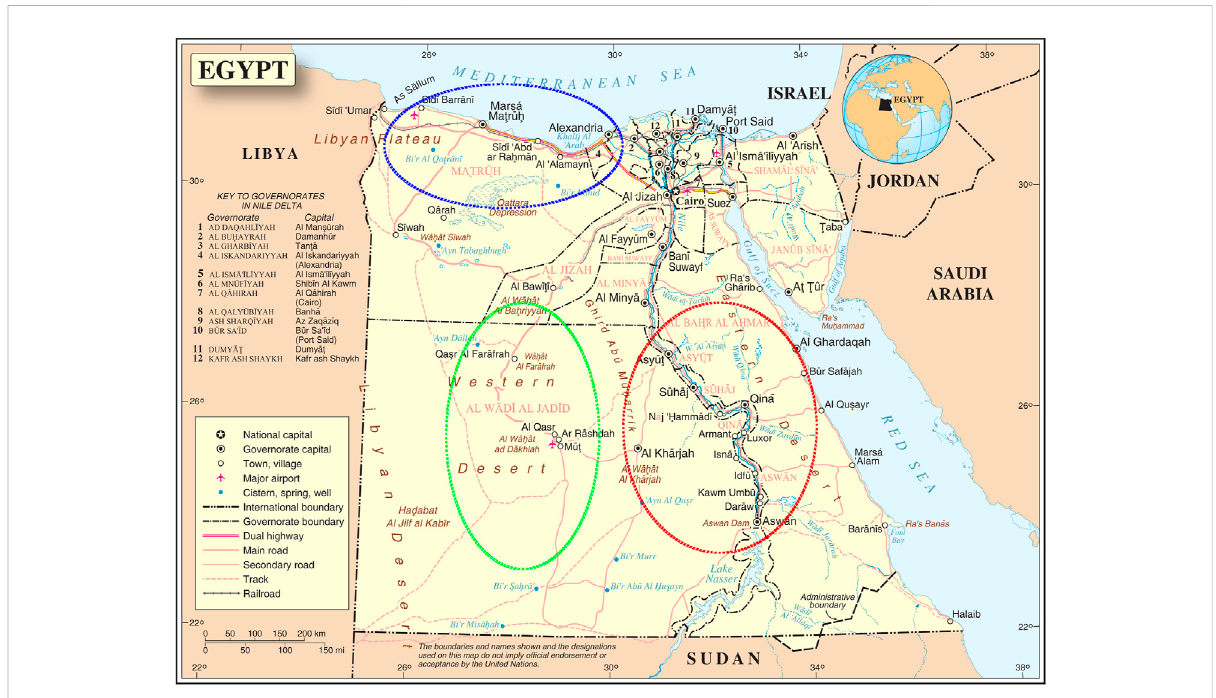
FIGURE 1 The three agroecological zones where local sheep breeds were collected. Western desert coastal zone (blue stroked), New Valley desert oasis (green stroked), and upper Egypt (red stroked) (map source united nations: